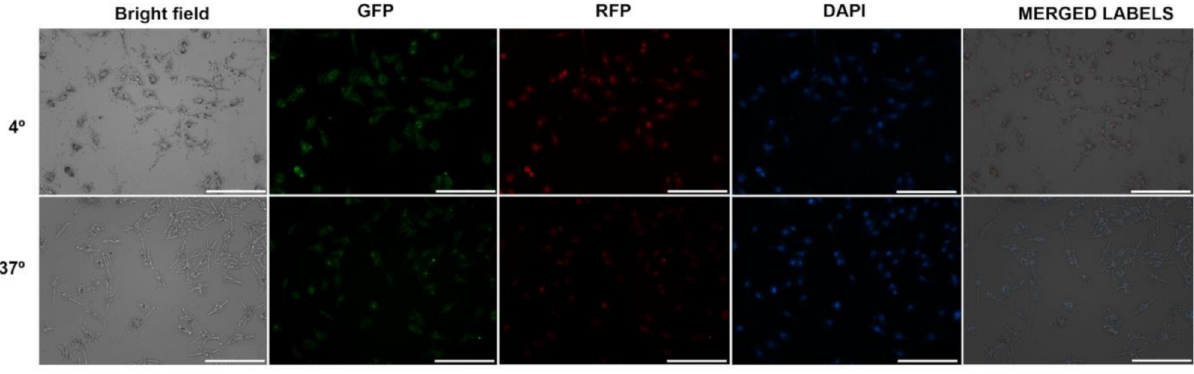
Figure 9. Microscopies (10 × ) of SK-Mel-28 cells after 4 h of incubation with F-UDL-Vis at 4 ◦ C (upper images) and 37 ◦ C (lower images). Green, red, and blue signals correspond to TopFluor ® cholesterol, propidium iodide, and DAPI, respectively. Filter cubes used to detect each fluorophore are indicated. Scale bar corresponds to 200 µ m.